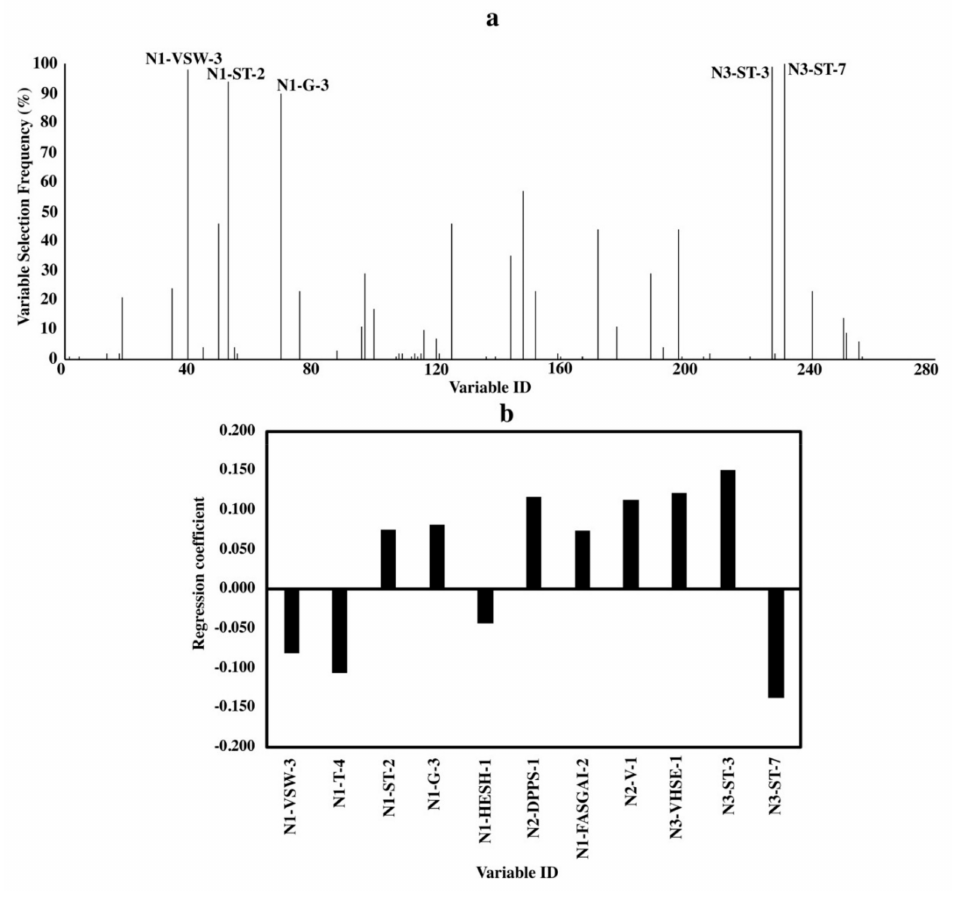
Figure 3. Variable importance of QSAR models for tripeptides. ( a ) Variable selecting frequencies of each variable from 100 BOSS runs; ( b ) standardized regression coe ffi cients of each variable based on the model with the smallest RMSECV from 100 BOSS